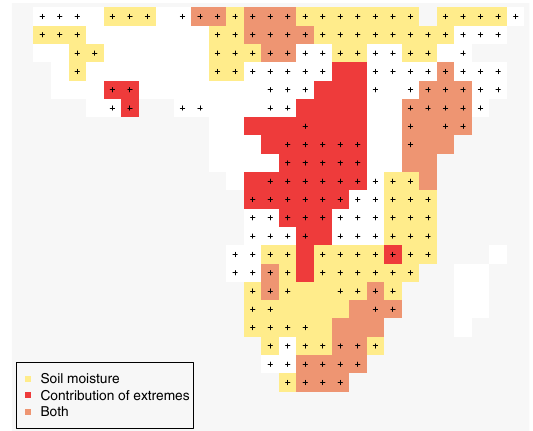
Figure 5. Results of optimizing a logistic regression model using a combination of the high-performing variables considered earlier. The model predicted whether there was any floodiness at the 50- year return period by using the following predictors: number of 3- day events in the 95th percentile (crosses), soil moisture (yellow), and the contribution of extremes (red). To optimize the model, we selected the most parsimonious combination of these three predic- tors that formed a glm that is within 1 standard error of the stan- dard error that could be achieved by the maximum fit. FPUs that are plain white showed no value in using any of the predictors, while locations with colors/symbols show which predictors were retained in the optimized model, either alone or in combination with other